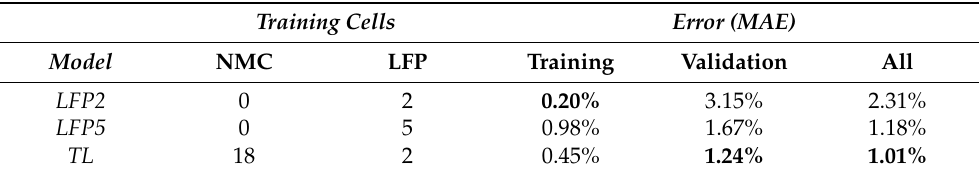
Table 3. Average prediction errors achieved for training and validation cells, and number of cells used for training, for LFP2, LFP5 and TL ageing models.